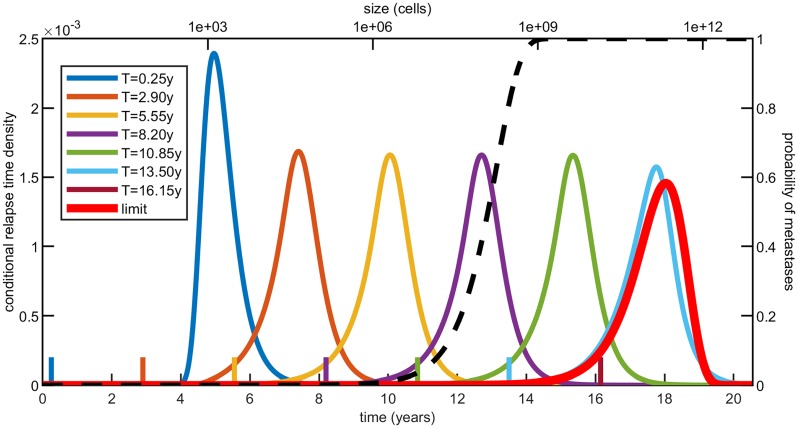
Relapse time densities fτ(t∣KT ≥ 1) conditioned on at least one metastasis initiated by the time of resection T.For different values of T, marked with ticks of corresponding colors, these densities are computed by differentiating Eq 8. As T becomes larger, the probability of metastases being established before resection (see Eq 1) increases and the conditional relapse time densities converge to the red limit one. Here we have used parameter estimates for colorectal cancer (see Table 2), n(t) = eδt and 7 equally spaced resection times between 0.25y and 16.15y. The curves for T > 15y look identical to the limit density.